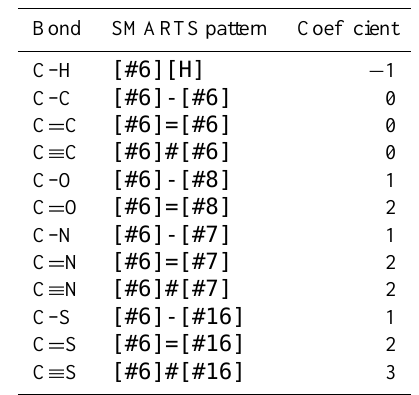
Table 3. List of SMARTS patterns and coefficients associated with each bond type, used to calculate the carbon oxidation state as de- scribed in the Sect.